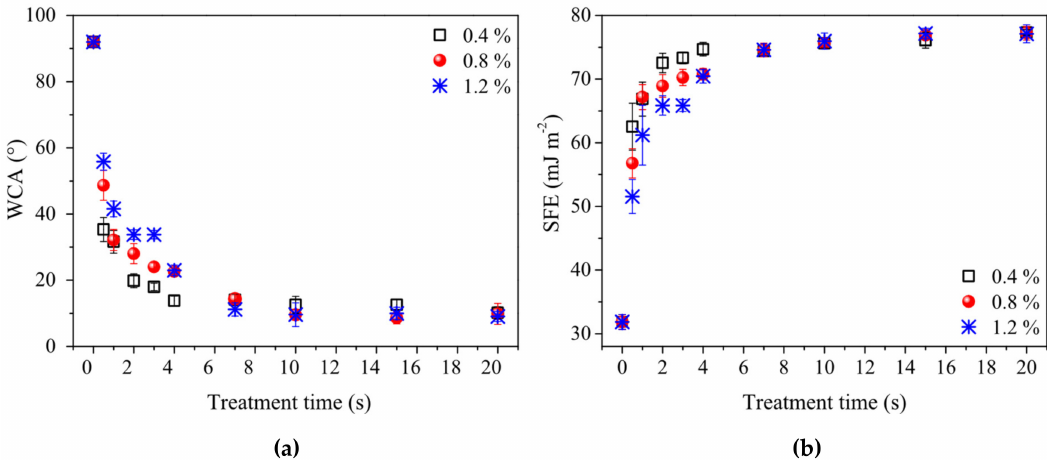
Figure 3. Dependences of surface parameters values on the plasma treatment time: ( a ) water contact angle (WCA); ( b ) surface free energy (SFE). Values for three di ff erent compositions of processing gas, i.e. 0.4, 0.8, and 1.2% of P-B in nitrogen, are shown.